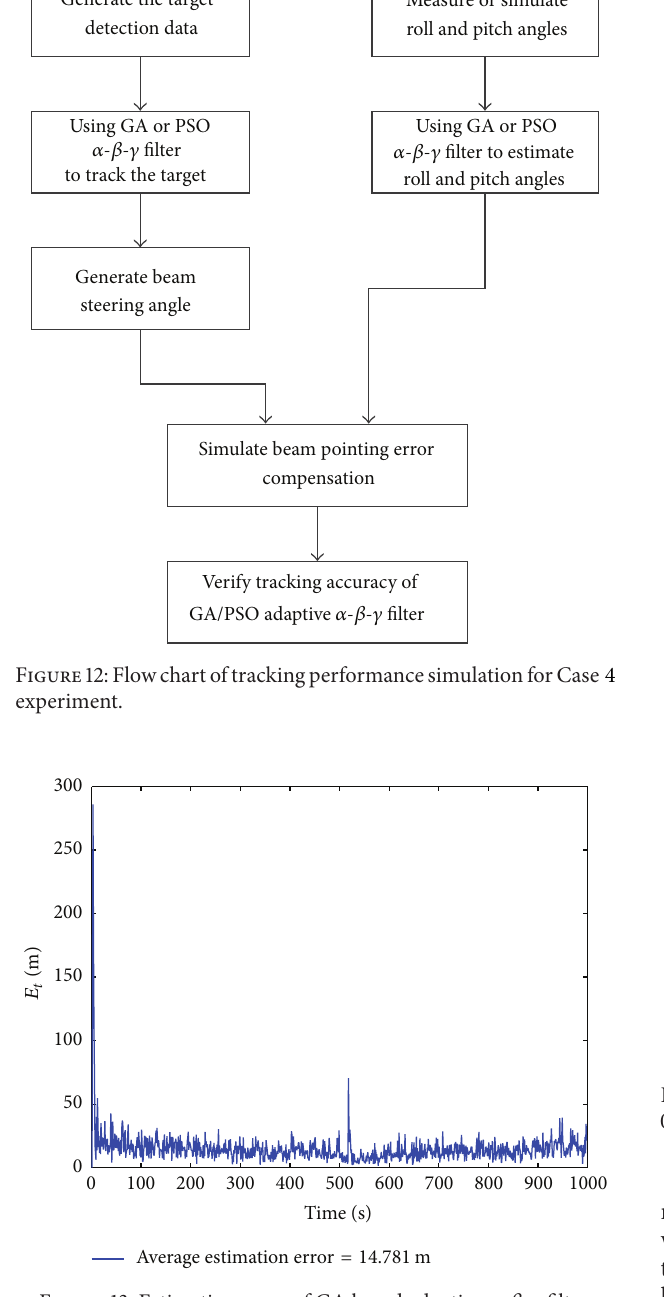
Figure 13: Estimation error of GA based adaptive 𝛼 - 𝛽 - 𝛾 filter.